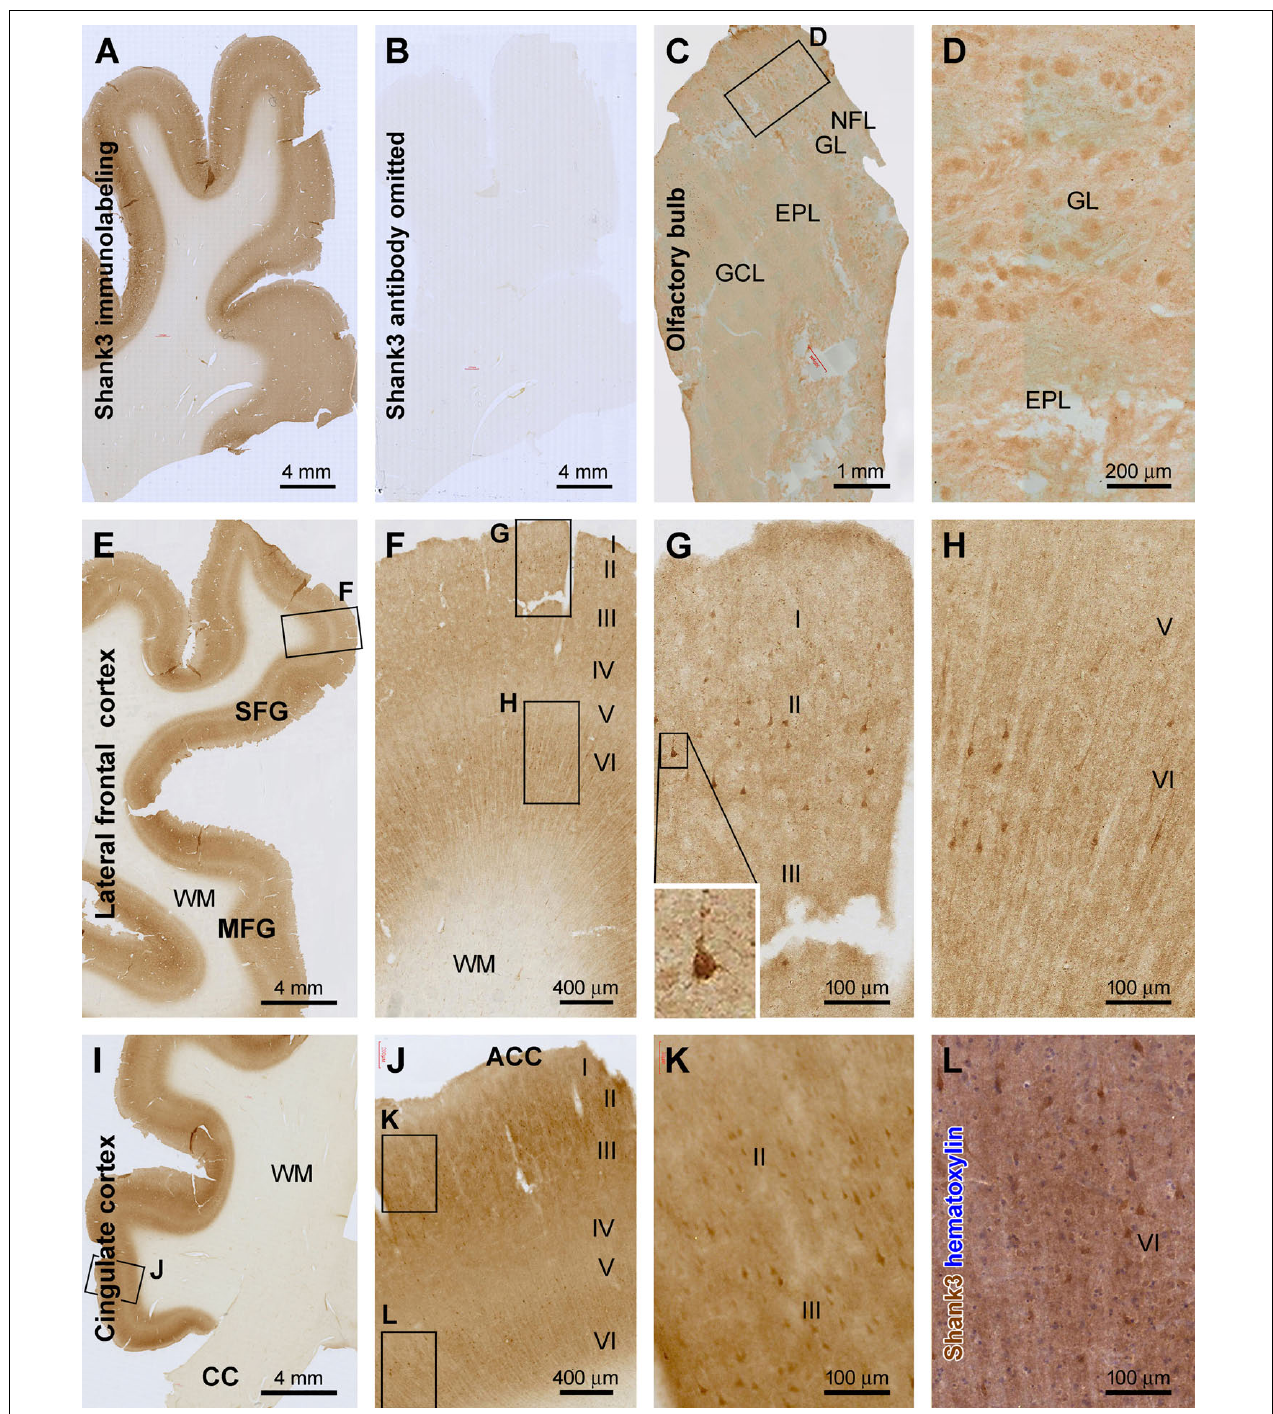
FIGURE 1 | Characterization of Shank3 immunoreactivity (IR) in the olfactory bulb (OB) and frontal lobe cortex. Panels (A,B) are images of medial frontal cortex from adjacent sections processed identically except for the omission of the primary antibody in the latter, which resulted in the lack of IR across the entire section (B) . (C) shows light diffuse IR across the OB, with the framed area enlarged as (D) , illustrating the labeling in individual glomeruli. (E–H) are low and high-power views of the labeling in the lateral frontal cortex, and (I–L) show IR in the anterior cingulate neocortex (ACC). Shank3 IR exhibits largely a neuropil-type pattern with the intensity noticeable higher in layers II–IV and VI than I and V. An apparently subset of pyramidal and multipolar neurons shows greater IR than the neuropil, which can be better recognized in the immunolabeled section with hematoxylin counterstain (L) . Additional abbreviations: CC, corpus collosum; NFL, nerve fiber layer; GL, glomerular layer; EPL, external plexiform layer; GCL, granule cell layer; WM, white matter; I–VI, cortical layers. Scale bars and panel orientation are as indicated in the panels.